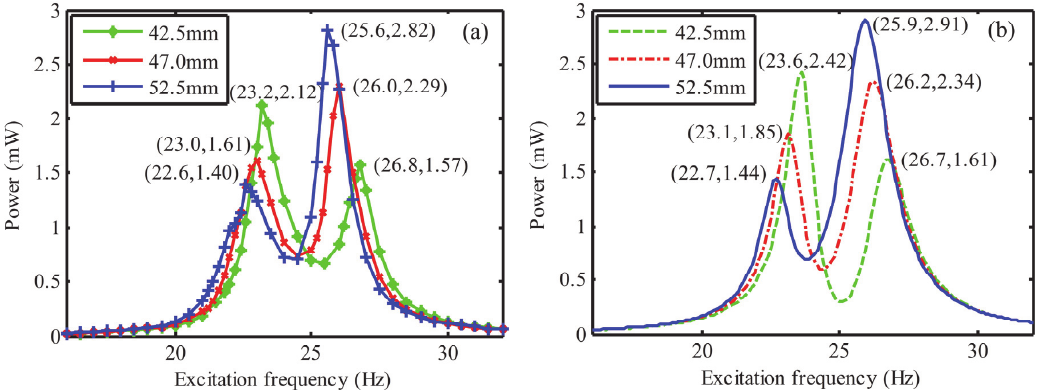
Figure 13. Frequency responses for the HEH with different separation distances d 0 : ( a ) experimental results; ( b ) numerical results.